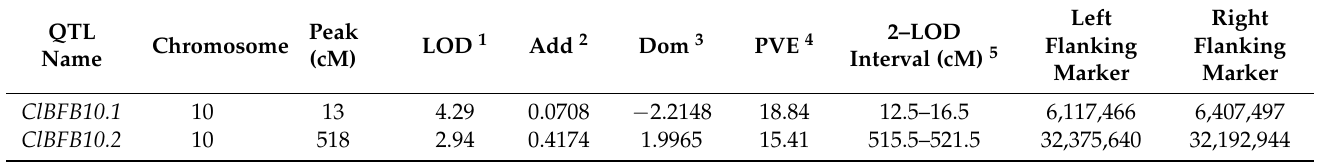
Table 1. Details of the quantitative trait loci (QTLs) identified for resistance to bacterial fruit blotch (BFB) in watermelon.